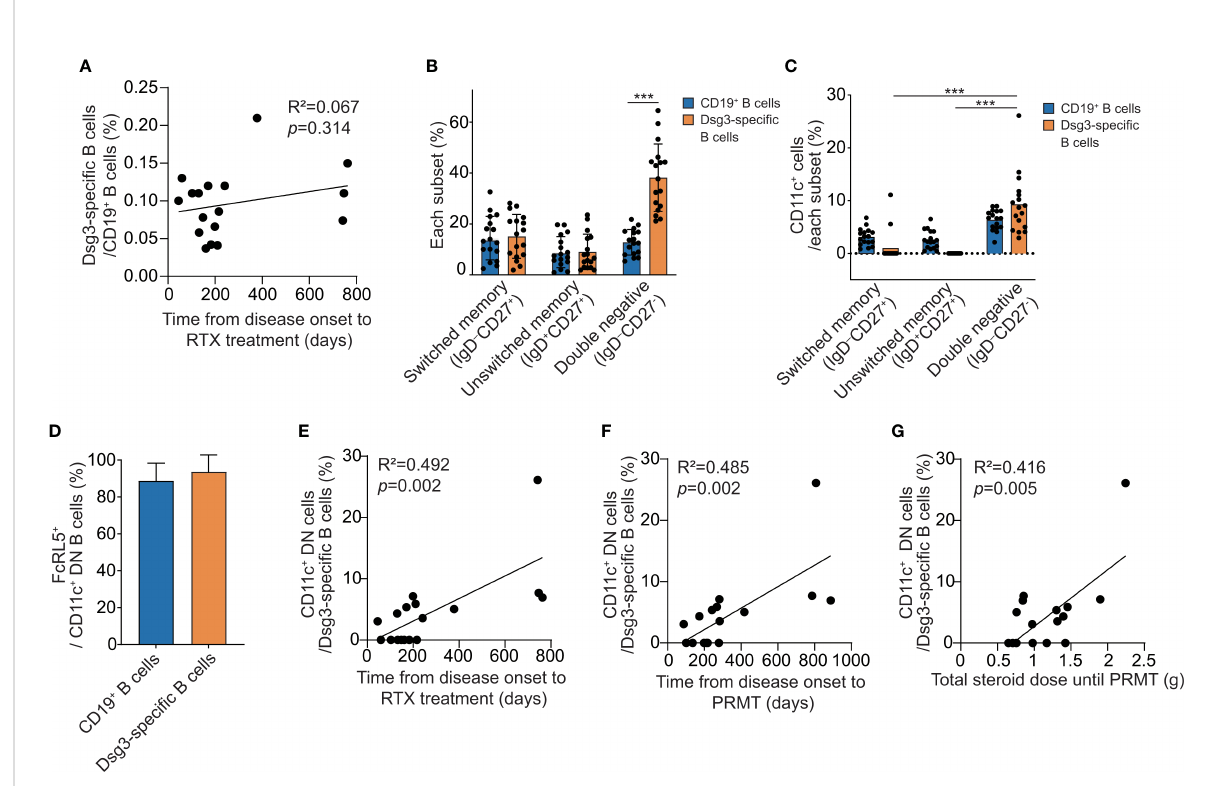
FIGURE 3 The analysis of Dsg3-speci fi c B cell subsets associated with clinical outcome after rituximab treatment. (A) Correlation between the time from disease onset to rituximab treatment and the proportion of Dsg3-speci fi c B cells within CD19 + B cells. (B) The proportions of switched memory (IgD - CD27 + ) B cells, unswitched memory (IgD + CD27 + ) B cells and DN (IgD - CD27 - ) B cells among CD19 + and Dsg3-speci fi c B cells were compared. (C) The proportions of CD11c + cells were compared among switched memory, unswitched memory, and DN cells from CD19 + and Dsg3-speci fi c B cells. (D) The proportions of FcRL5 + cells in Dsg3-speci fi c CD11c + DN B cells and CD19 + CD11c + DN B cells are shown. (E – G) Correlation analyses of the proportion of CD11c + cells among Dsg3-speci fi c DN B cells were performed for (E) the period from the onset to the administration of rituximab, (F) the time from the onset of the disease to reaching PRMT, and (G) the total corticosteroid intake until reaching PRMT. *** p < 0.0001. RTX, Rituximab; DN, Double-negative; PRMT, Partial remission under minimal